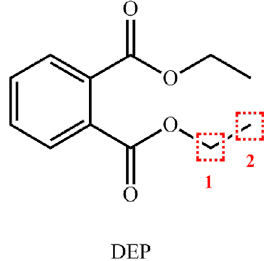
Figure 2. Molecular structure of the target molecule diethyl phthalate (DEP).